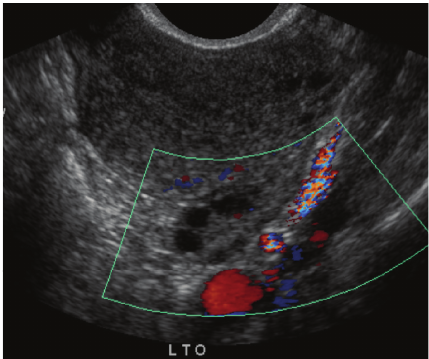
Figure 2: Pelvic ultrasound 5/31/13: unremarkable scan, picture showing normal left ovary with the normal Doppler